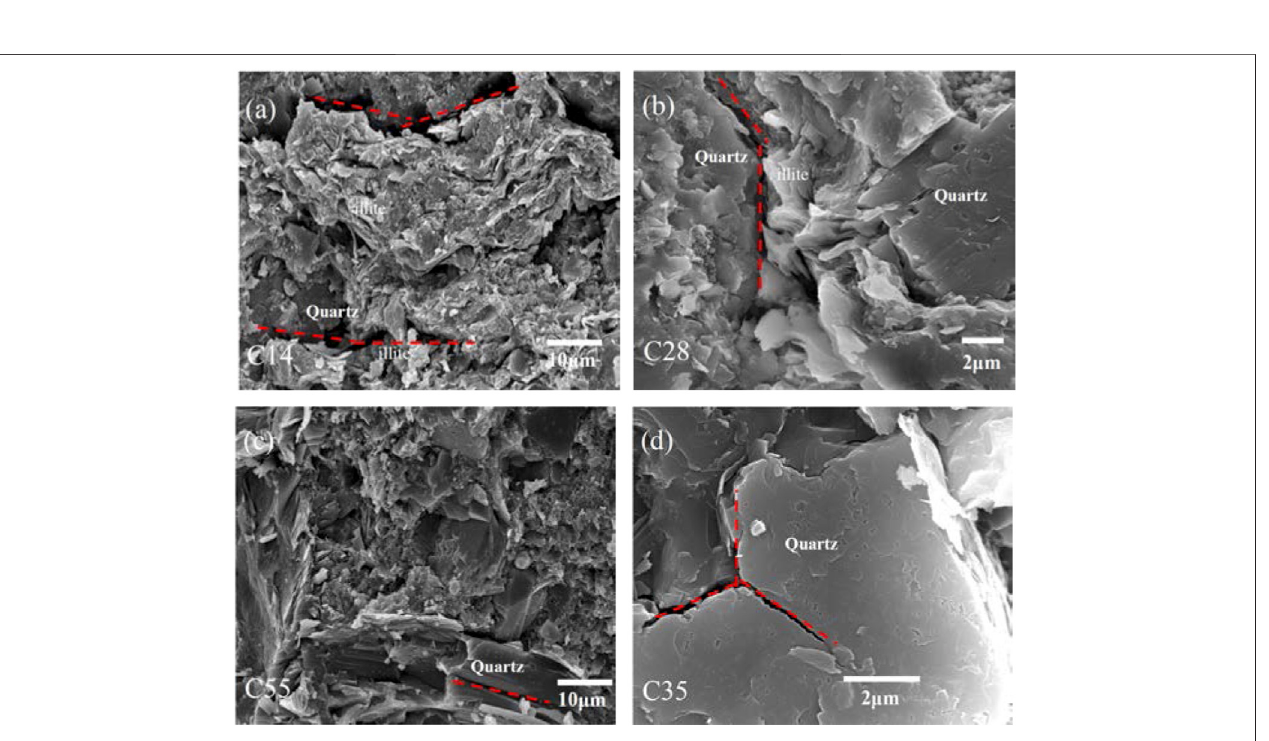
Frontiers in Earth Science |